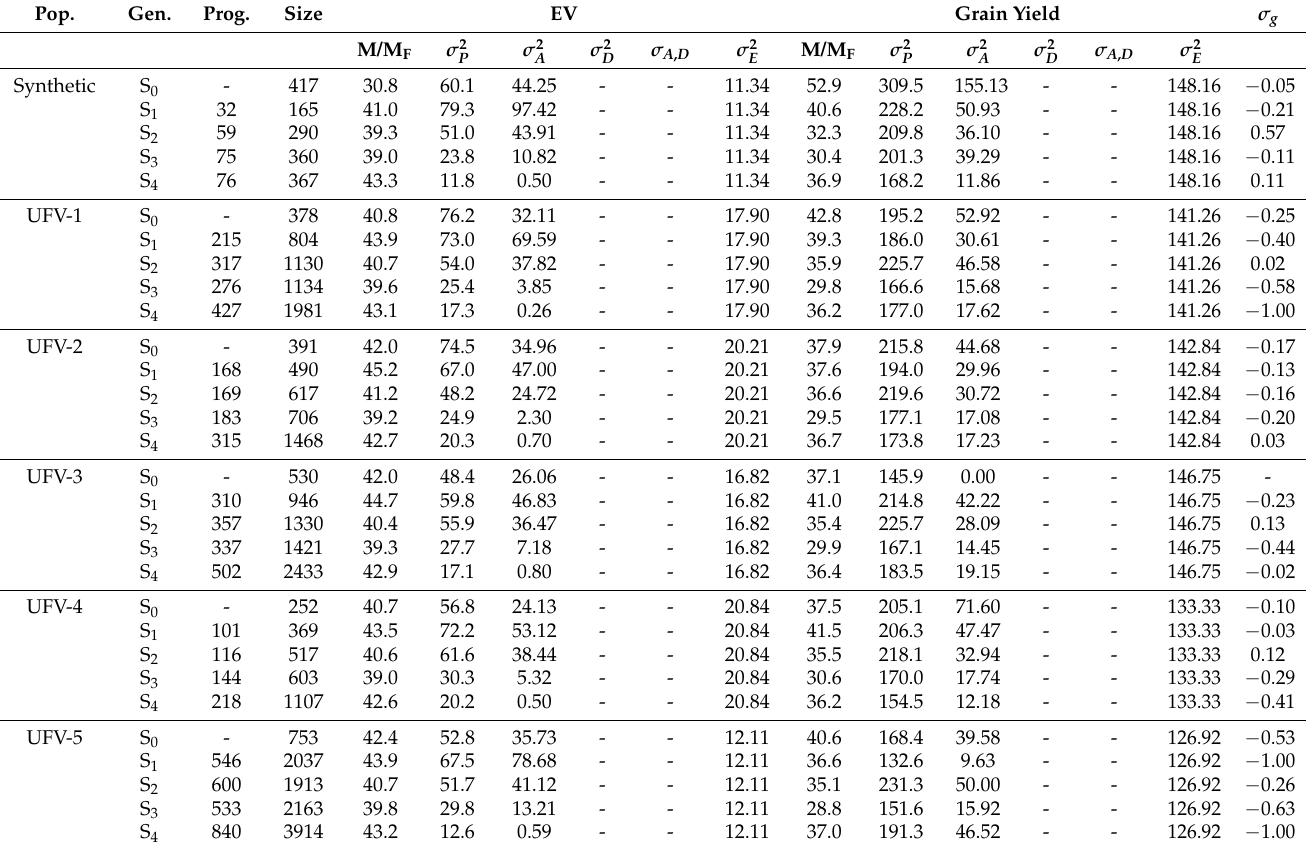
Table 1. Number of progeny, sample size, mean (M/M F ), phenotypic ( σ 2 ( σ 2 ), and error ( σ 2 ) variances, covariance between additive and dominance values ( σ A , D ), and D E genotypic correlation ( σ g ), per generation, in the popcorn (estimates) and in silico (estimates in the 2nd row) populations, relative to EV (mL/g) and grain yield (g/0.18 m 2